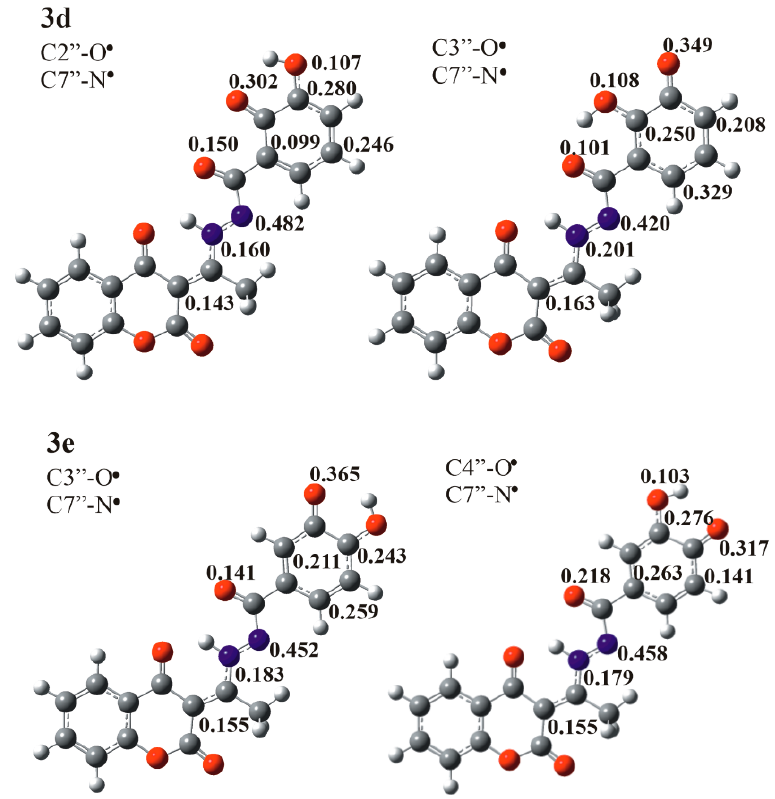
Figure 4. NBO spin delocalisation of 3d and 3e biradicals obtained through the DHAT mechanism.